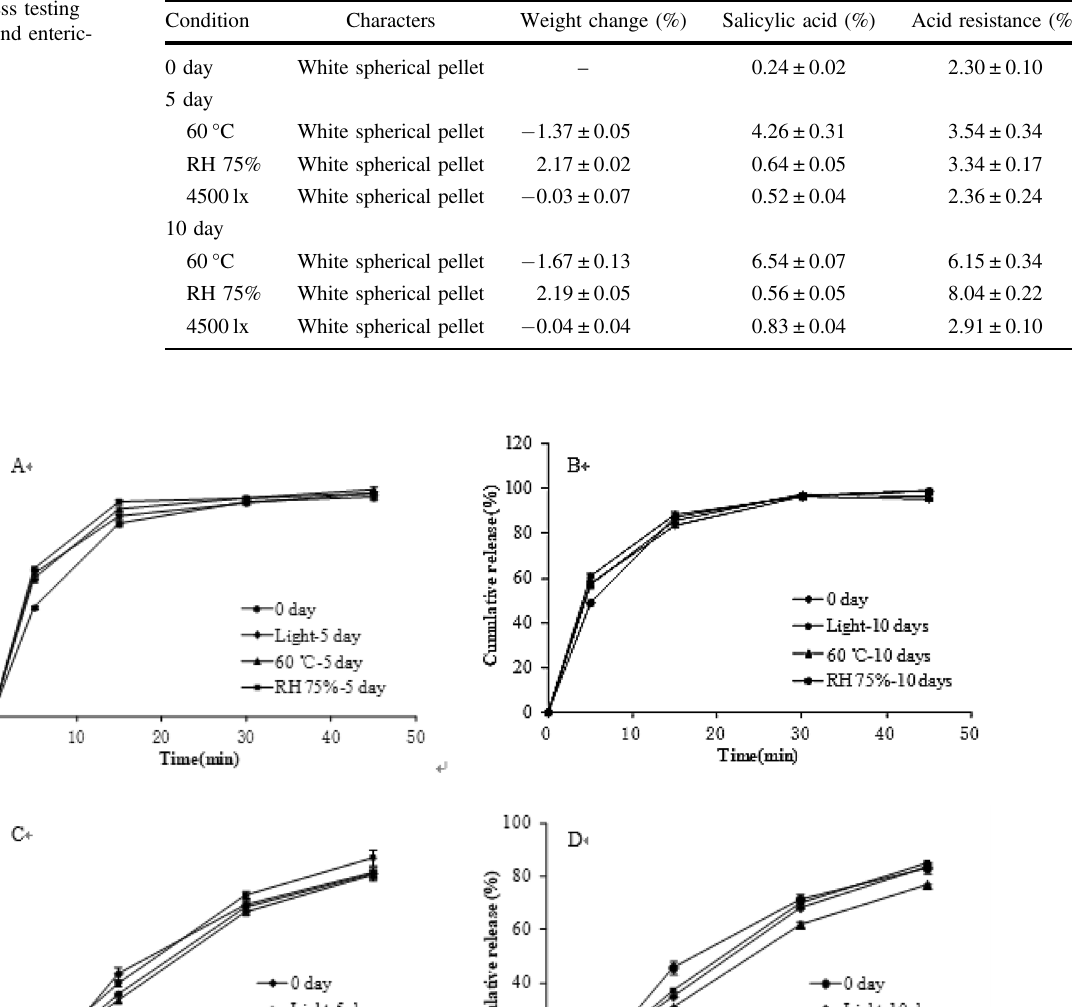
Table 12 The stress testing results of compound enteric- coated granules